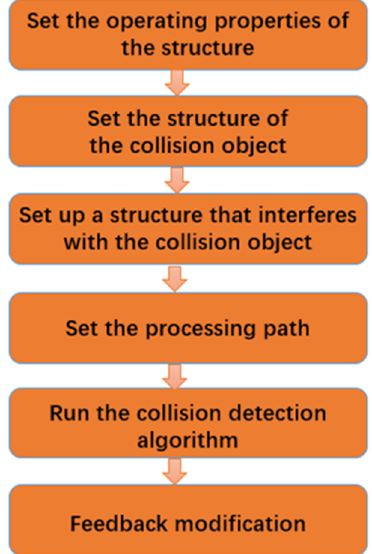
Figure 5. Flow chart of collision inspection.